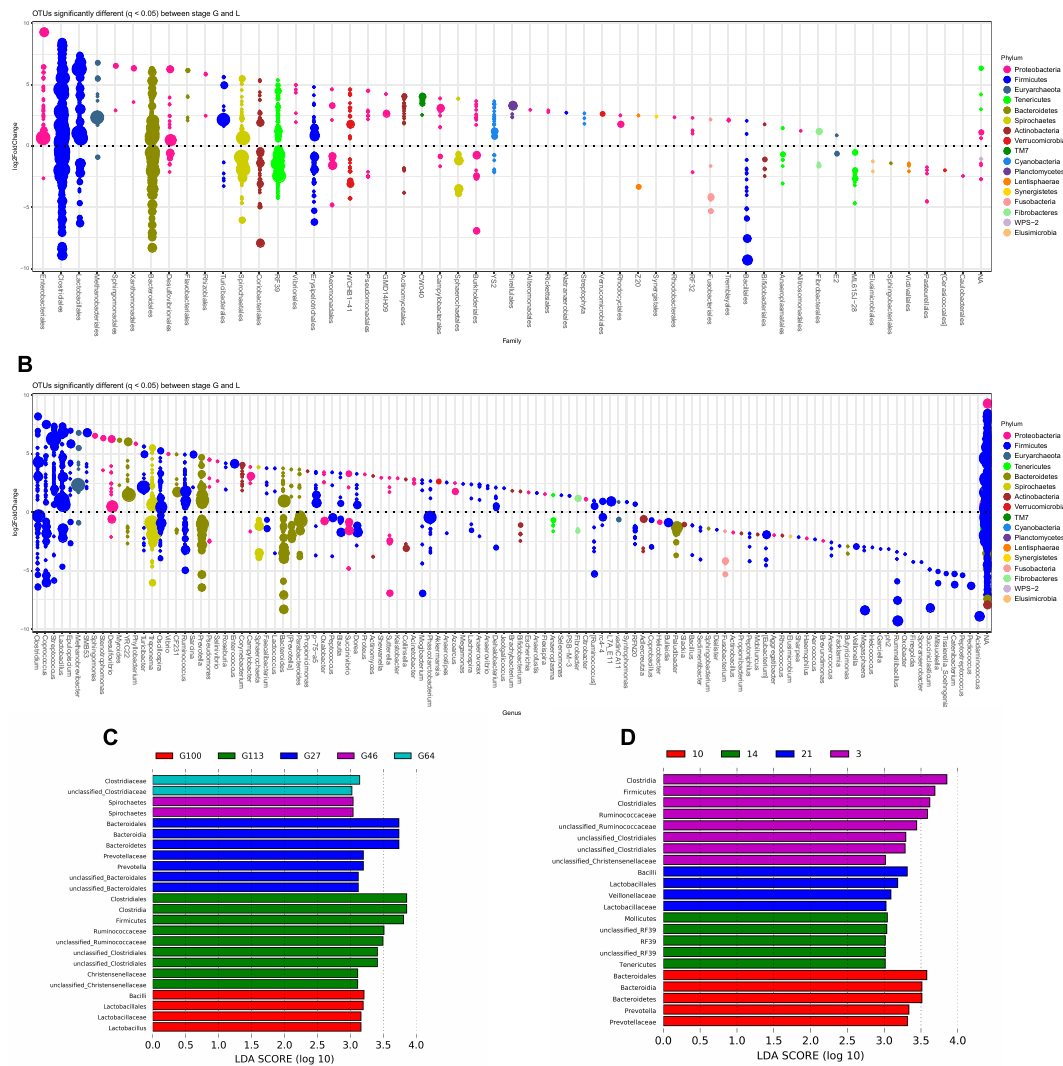
Figure 3. Di ff erent bacteria compositions in the perinatal period of sows. ( A ) The di ff erence in bacteria composition between the prenatal and post periods at the family level; ( B ) the di ff erence in bacteria composition between the prenatal and post periods at the genus level; ( C ) the di ff erences in bacteria composition at di ff erent time points during the prenatal period; ( D ) the di ff erences in bacteria composition at di ff erent time points during the postnatal